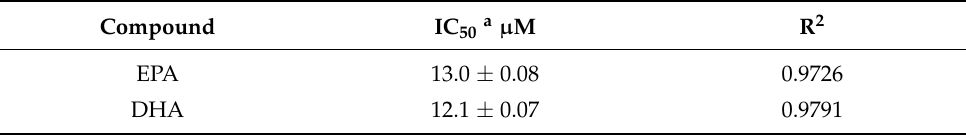
Table 1. The IC 50 values were calculated using ANS displacement binding assay.